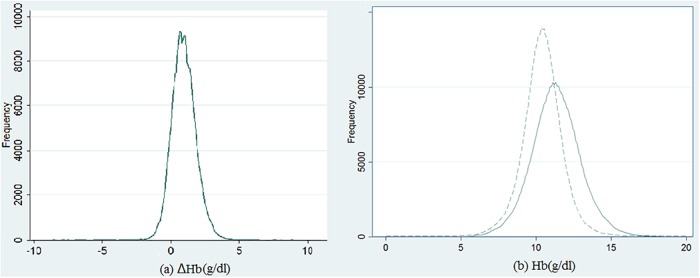
Histogram with kernel density estimation of (a) difference in hemoglobin levels before and after hemodialysis (ΔHb), and (b) pre-hemodialysis and post-hemodialysis hemoglobin.Solid line presents post-hemodialysis hemoglobin, and dashed line presents pre-hemodialysis hemoglobin.